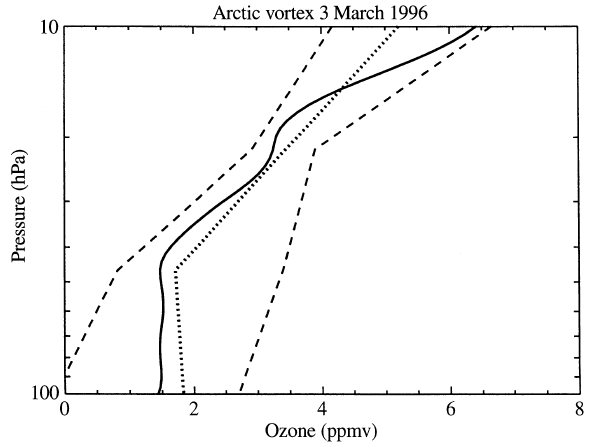
Fig. 14. The ozone profile observed by HALOE on March 3, 1996 at 51.9 (cid:14) N and 24.3 (cid:14) E inside the vortex ( solid line ) compared with 14 MLS (Version 4) profiles (G.Manney, personal communication 1997). The MLS data were selected to fulfil the following requirements: (1) latitude between 45 (cid:14) and 60 (cid:14) N: (2) longitude between 340 (cid:14) and 360 (cid:14) or 0 (cid:14) and 60 (cid:14) E: (3) UKMO PV at 465 K greater than 2.5 10 (cid:255) 5 K m 2 (kg s) (cid:255) 1 , so that they are comparable with the HALOE measure- ments. The two dashed lines show the range of the MLS observations, their mean value is indicated by the dotted line . The comparable values for the column ozone above 100 hPa are 197 DU and 195 DU for HALOE and MLS respectively